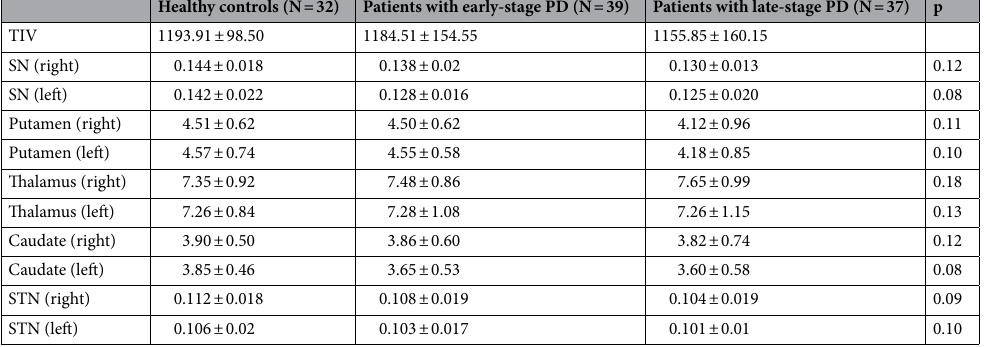
Healthy controls (N = 32) Patients with early-stage PD (N = 39) Patients with late-stage PD (N = 37)